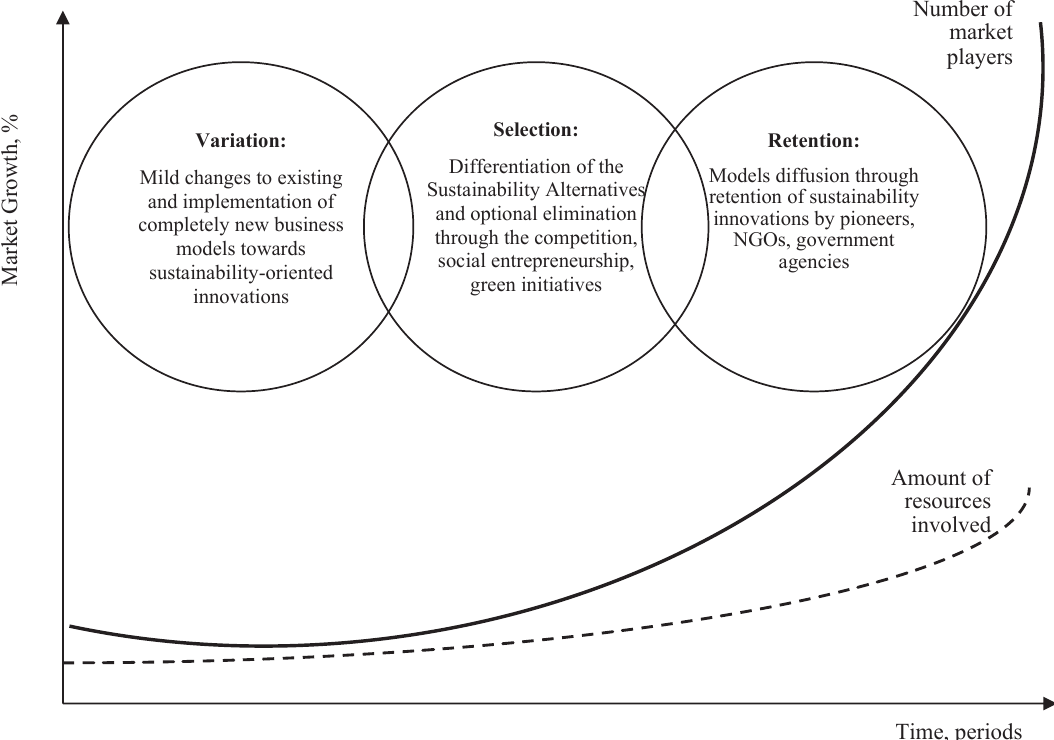
Fig. 1. The evolutionary processes in the market towards